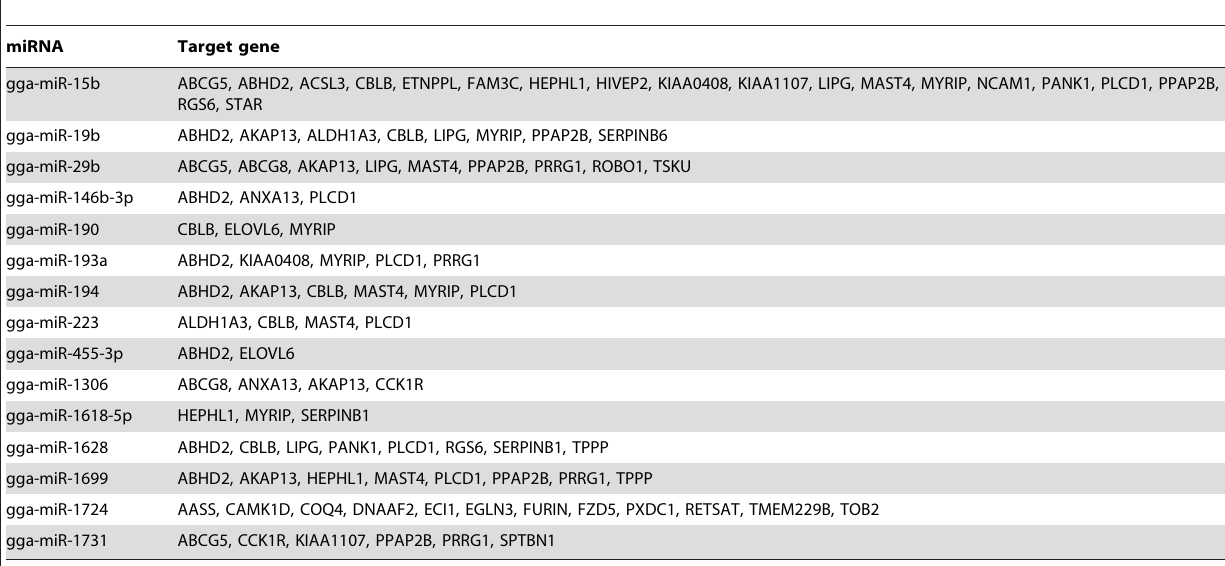
Table 9. GH-regulated chicken genes predicted to be targeted by GH-regulated chicken miRNAs.